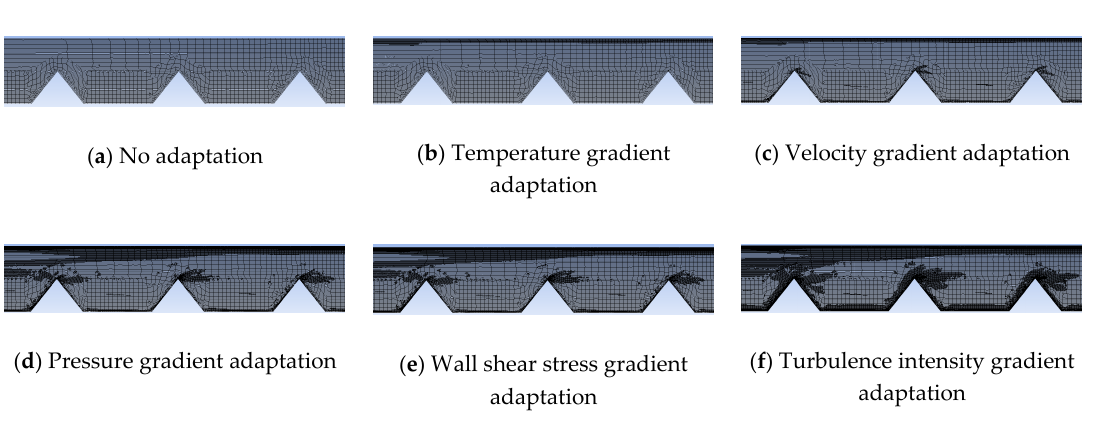
Figure 4. Grid system after successive gradient adaptations for a fixed value of pitch ( P = 150 mm) and length ( l = 65 mm), and different value of height ( e ) at Reynolds number of 12,000. Table 3. Number of cells and Nusselt number after each gradient adaptation for a solar air heater with a transverse triangular block at the bottom of the air duct for fixed value of height ( e = 40 mm), pitch ( P = 150 mm), length ( l = 65 mm), and Reynolds number ( Re = 12,000). Gradient Adaptation